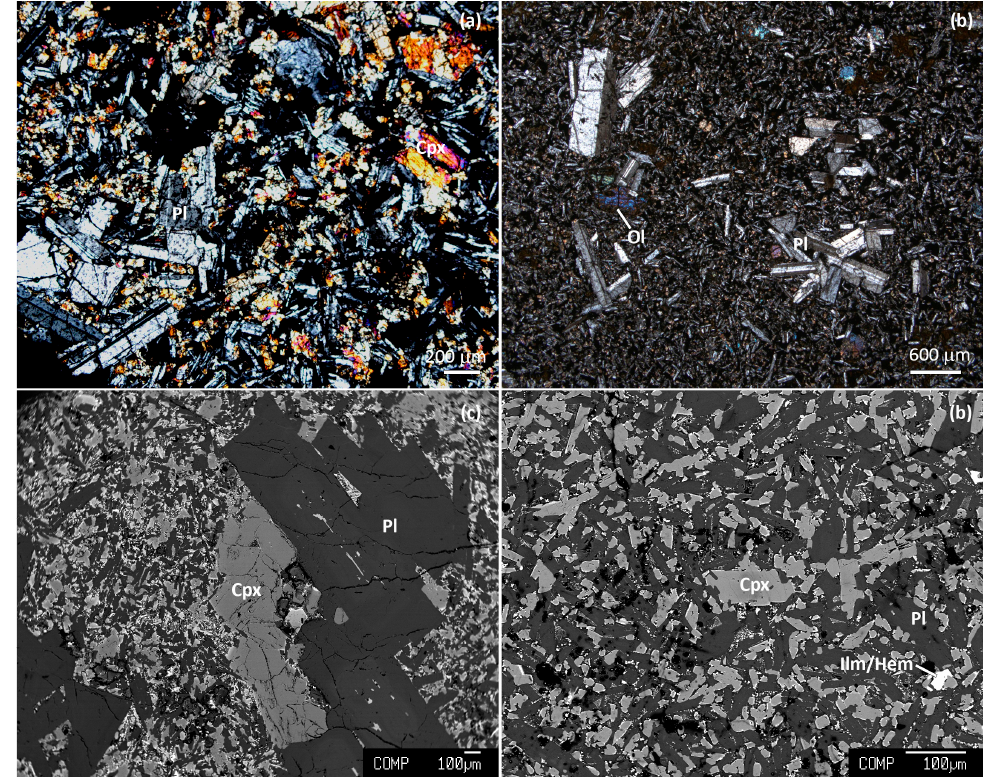
Figure 4. Cross-polarized light images of ( a ) Maharajpur basalt showing plagioclase (Pl) and clinopyroxene (Cpx) phenocrysts, and ( b ) Tinpahar basalt showing Pl and olivine (Ol) phenocrysts, and backscattered electron images of ( c ) Taljhari basalt showing Pl and Cpx phenocrysts, and ( d ) Kherwa basalt showing Pl and Cpx microphenocrysts surrounded by a fine-grained groundmass comprising Cpx, Pl, ilmenite (Ilm), and hematite (Hem).